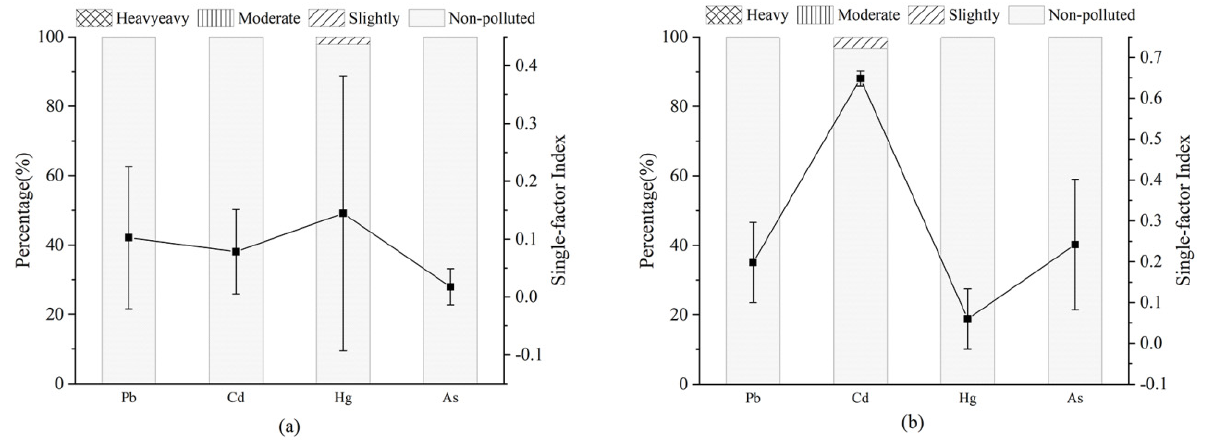
Figure 5. Single-factor pollution level of asparagus ( a ) and soil ( b ) in Chongming Island. The Nemerow comprehensive pollution levels of asparagus and soil sampled in spring and summer were all safe (Table 5). The NPI of the eastern asparagus in spring was